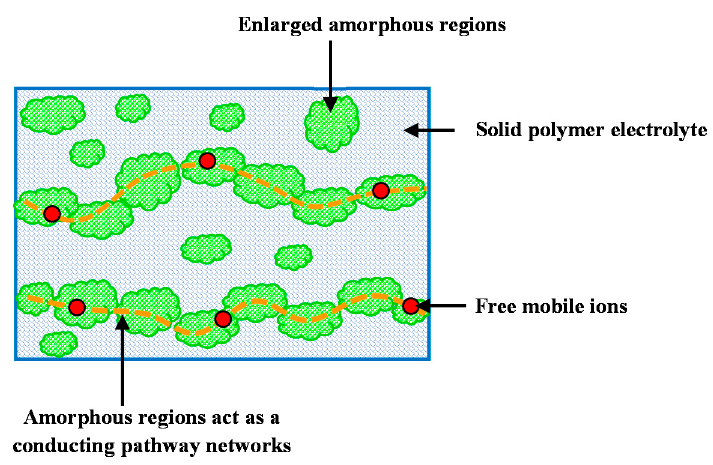
Figure 2. Percolative network of disordered regions produces rapid ion transport pathways for the mobile ions [5].